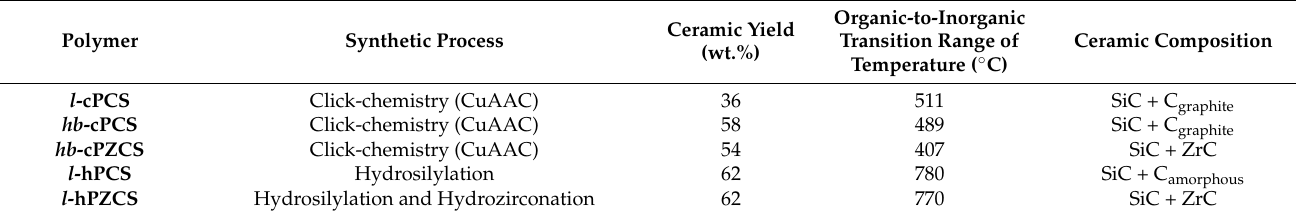
Table 2. Some characteristics of the preceramic polymers regarding their thermal behaviour and ceramisation. Polymer